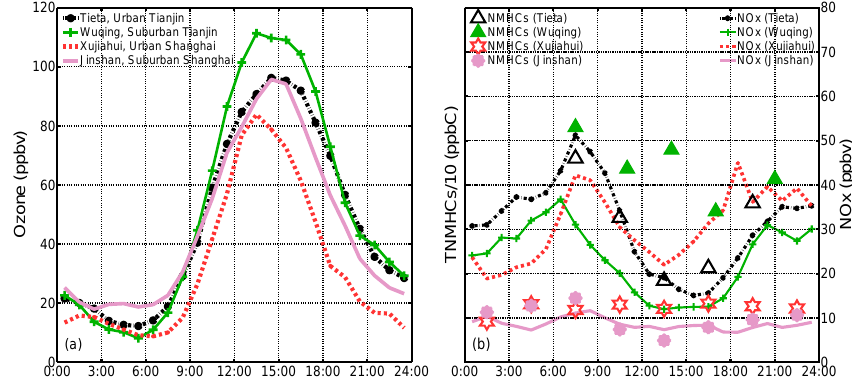
Fig. 4. Average diurnal cycles of (a) ozone and (b) its precursors on selected days (the selection criteria have been described in Sect. 2.2). Table 2. Top 10 species sorted by contributions to total OH reactivity at the four